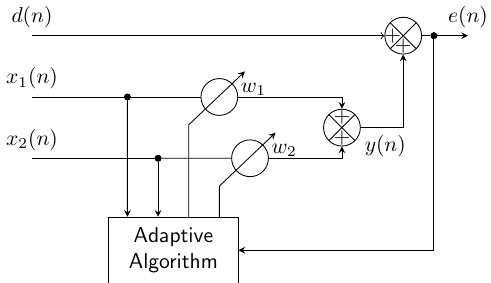
Figure 17. Block diagram of the notch adaptive